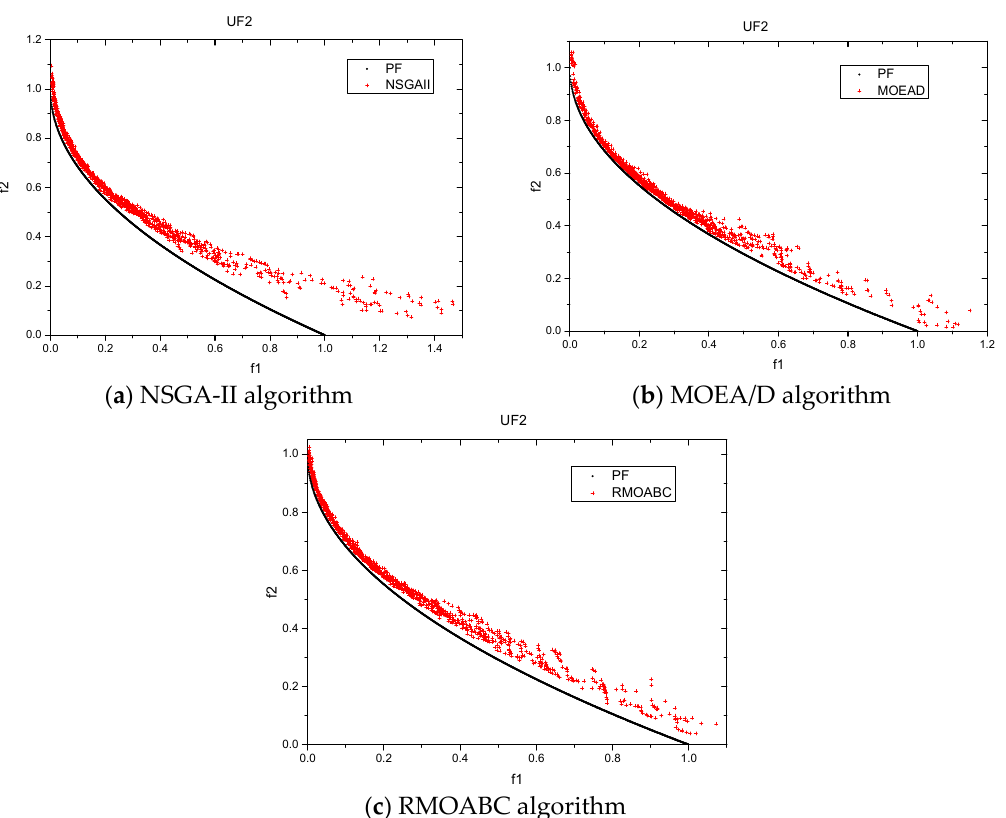
Figure 6. Plots of the non-dominated front found by the three algorithms for 2-objective UF2 test instance. ( a ) NSGA-II algorithm; ( b ) MOEA/D algorithm; ( c ) RMOABC algorithm.